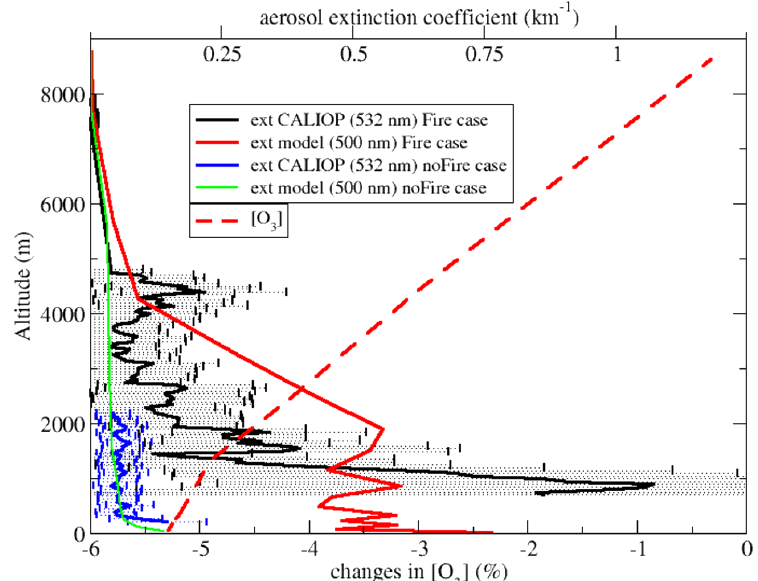
Figure 8. The aerosol extinction coefficient (in km − 1 ) modeled by CHIMERE and measured by CALIOP for the 9 August inside (Fire case, 37.6 ◦ E, 59.9 ◦ N) and outside (noFire case, 33.3 ◦ E, 52.0 ◦ N) the intense aerosol plume (dotted lines correspond to the uncertainties on CALIOP measurements). The localization of these two points is indicated on Fig. 1. The vertical profile of the daytime average percentage changes in the ozone concentration due to this intense aerosol plume is indicated by the red dashed line. Table 3. As Table, 1 but for the near-surface concentrations of ammonium, nitrates and sulfates. Measurements come from the Danki EMEP station RU0018R (near Moscow) located at 54.9 ◦ N and 37.8 ◦ E. NH + 4 NO − 3 SO 2 − 4